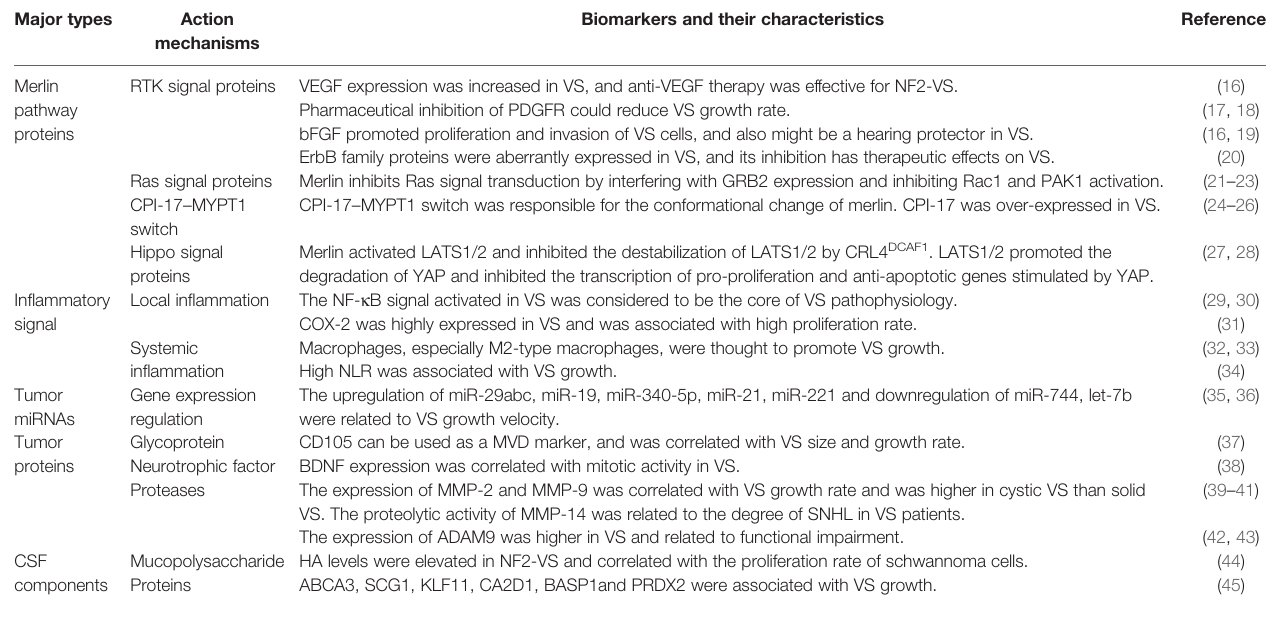
TABLE 1 | Summary table of potential biomarkers related to VS